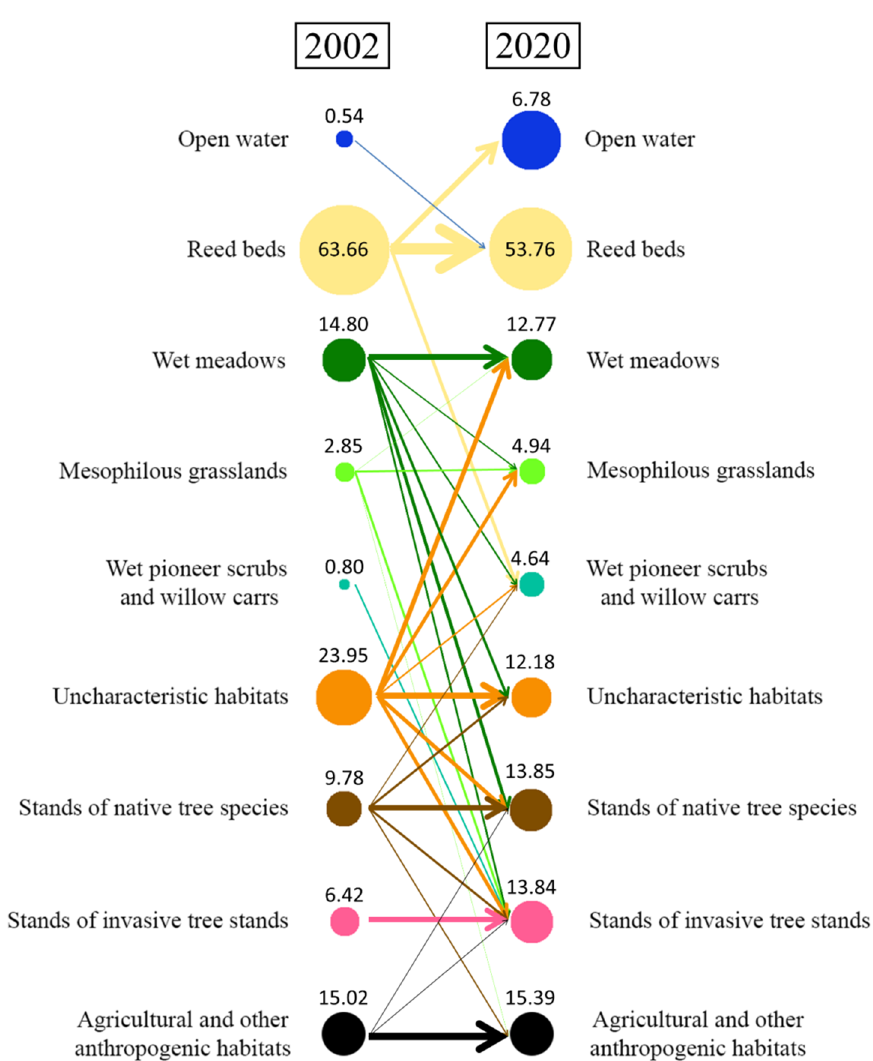
Figure 4. Transitions between habitat category groups in hectares and in percentage of the former area of the original habitat category group.